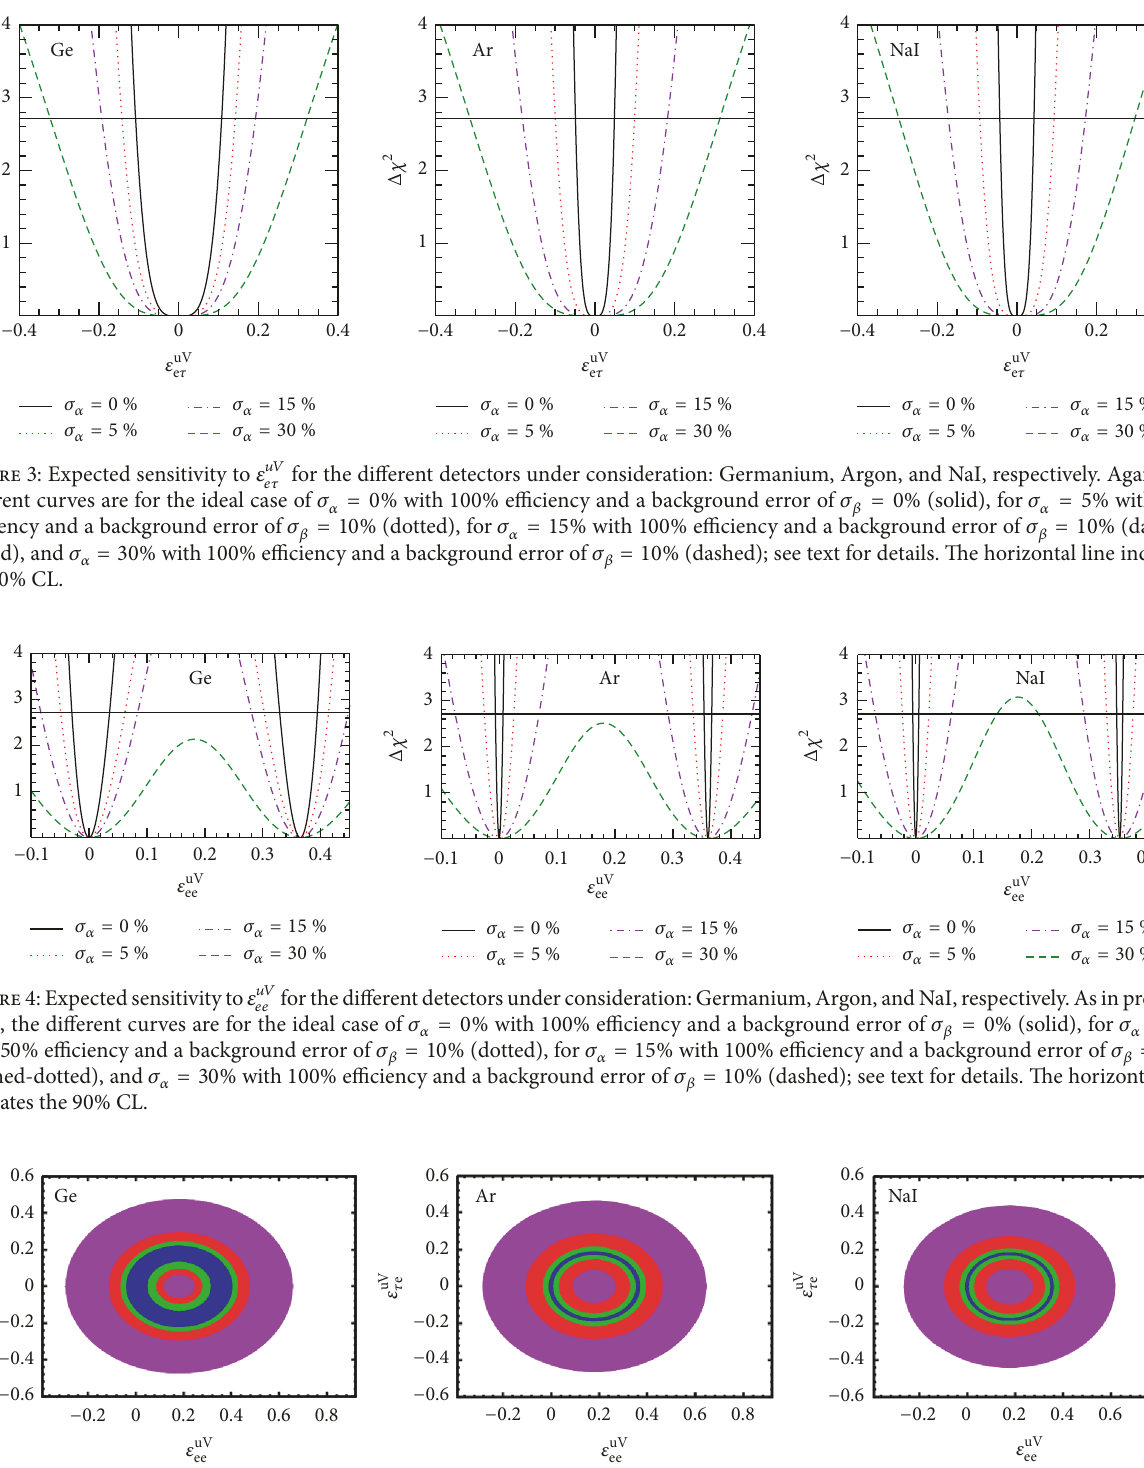
= 10 % (green), for 𝜎 = 15 % with 100 % efficiency and a 𝛽 𝛼